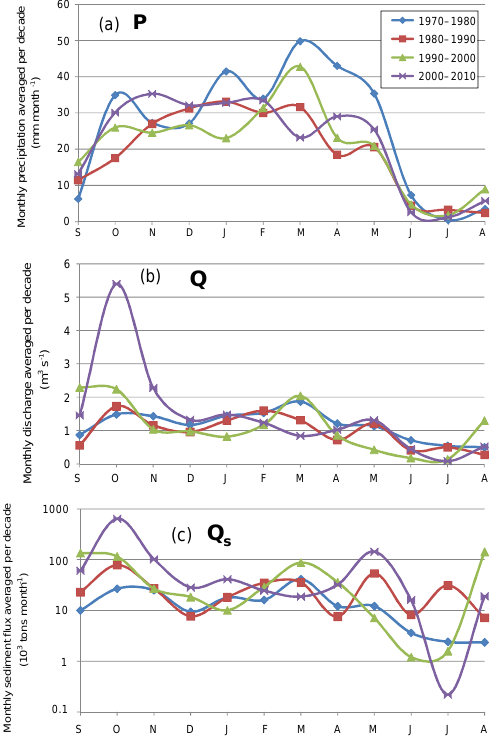
Figure 12. Monthly values of precipitation (a) , Q (b) and Q s (c) averaged over decades in the Wadi Abd